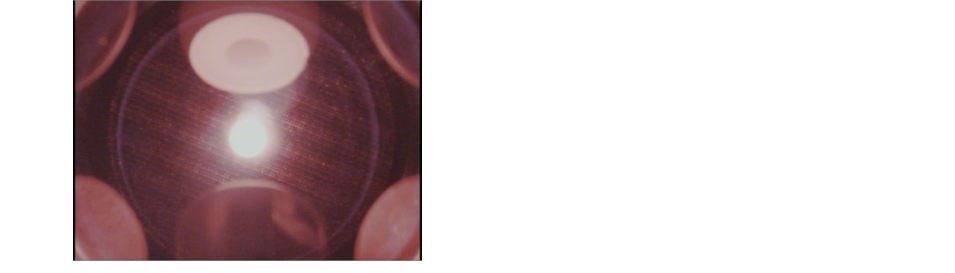
Figure 1. A positively charged sample levitating among 3 pairs of electrodes in the ISS-ELF. The sample is heated by four semiconductor lasers (980 nm, 40 W power each) in which beams are focused to a 0.5 mm spot size at the sample position. To maintain good geometry around the sample. Furthermore, the power of each laser can be controlled by commands from the ground.